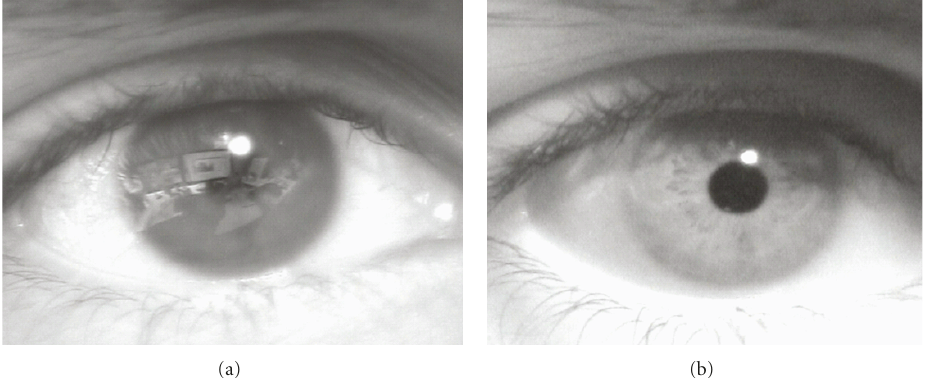
Figure 6: The image illustrates eyes captures with and without the X-Nite715 near infrared (IR) filter. This filter is an passes near IR wavelength with 50% transmittance at 715nm. We see that the iris pattern details are clear when we image in the near IR spectrum.